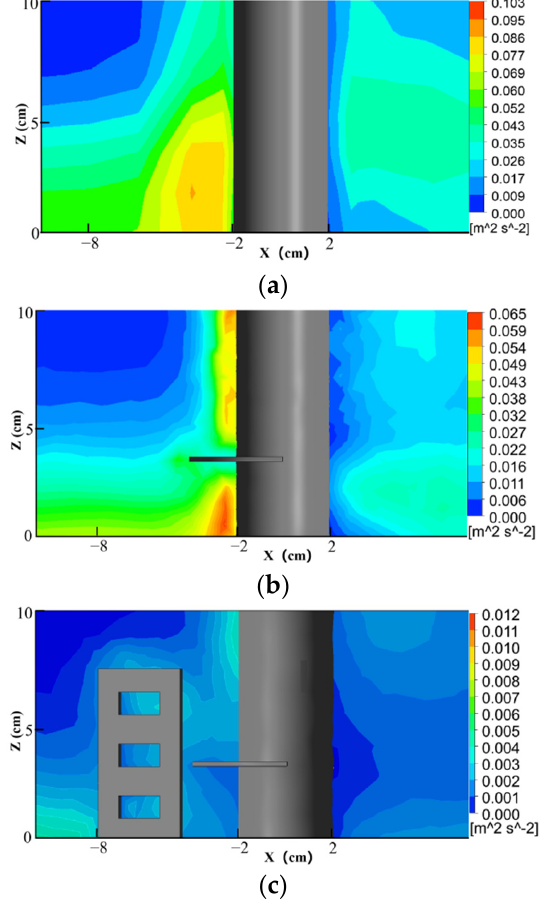
Figure 18. Turbulence kinetic energy at Y = 0. ( a ) Single pier; ( b ) Pier with ring-wing plate; ( c ) Pier with combined device.